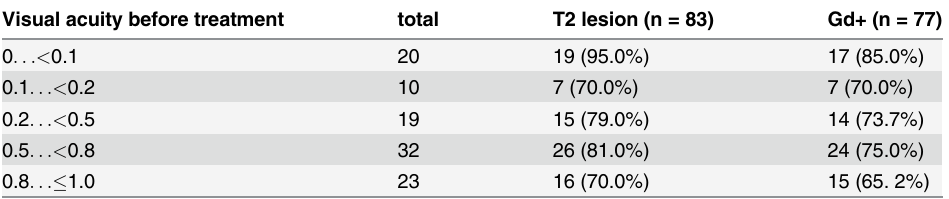
Table 3. Visual categories (acc. ONTT). Visual acuity before